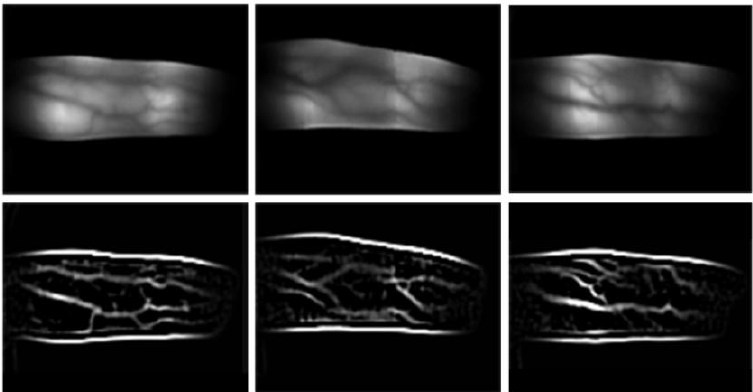
Figure 5. Down-sampled finger images (top) and their filtered